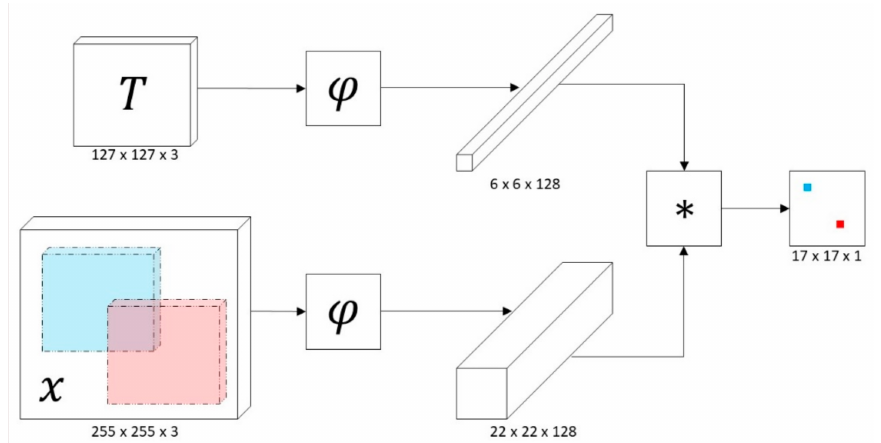
Figure 4. Siam-FC